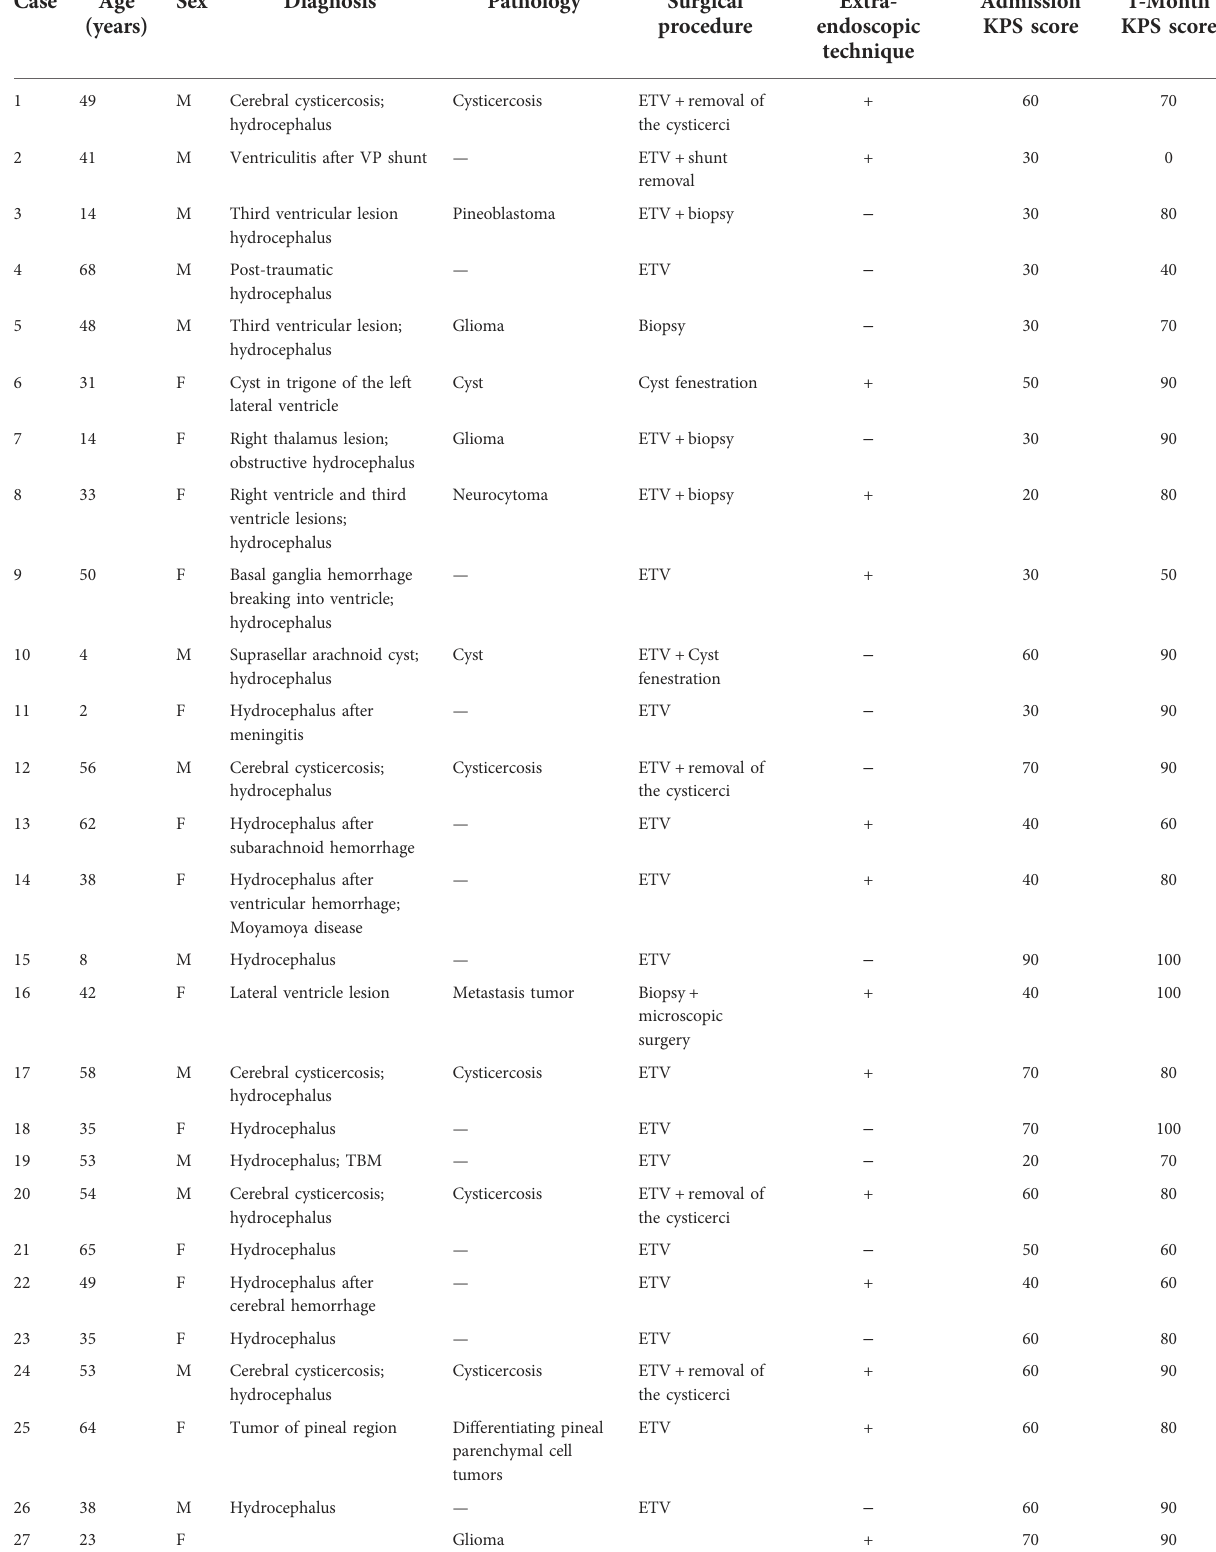
TABLE 1 Patient